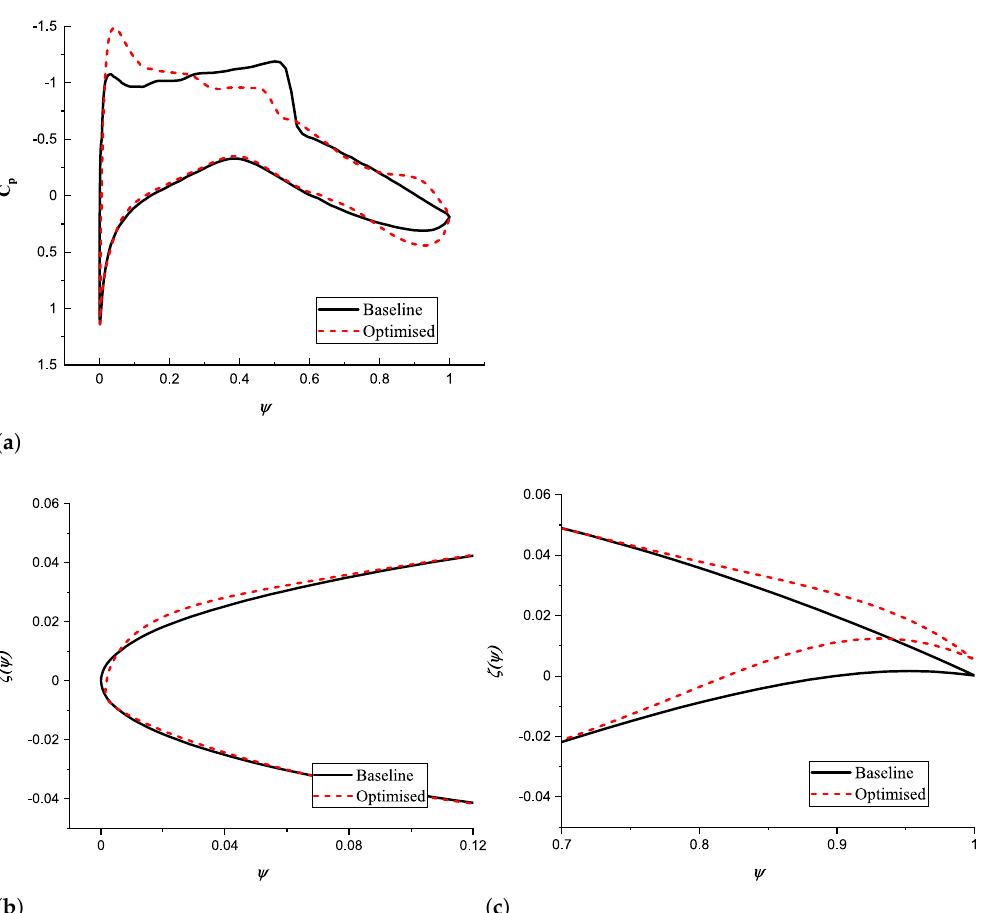
Figure 12. Comparison of results for the RAE 2822 optimization using morphing leading and trailing edges, starting from the optimized morphing leading edge case. ( a ) C p distribution. ( b ) Leading edge shape. ( c ) Trailing edge shape.